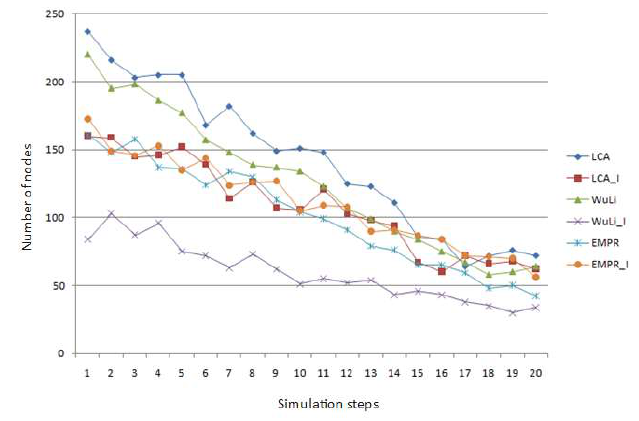
Initially, the reference node is placed in the center of the simulation area, and the other nodes are placed evenly over the simulation surface. The simulation surface on which the network is placed has dimensions of 400x400, the radius of coverage of the nodes is 45, and the total number of nodes is 600. Figure 9 shows the characteristic results of a 20-step simulation for this scenario.